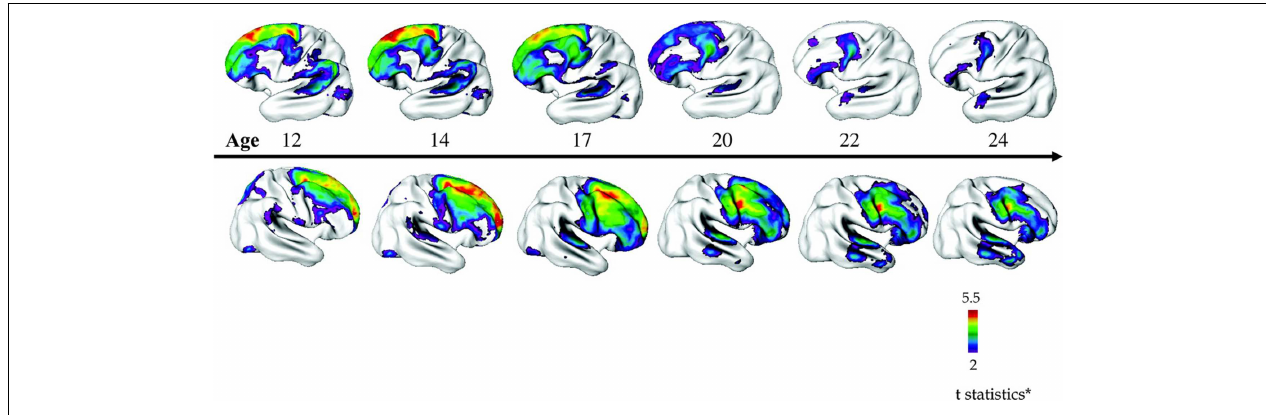
FIGURE 3 | Progressive loss of cortical thickness in a “front to back” pattern observed through longitudinal imaging of 70 children with COS compared to 72 control participants . Reproduced with permission from Gogtay (160), adapted from Greenstein et al. (46).